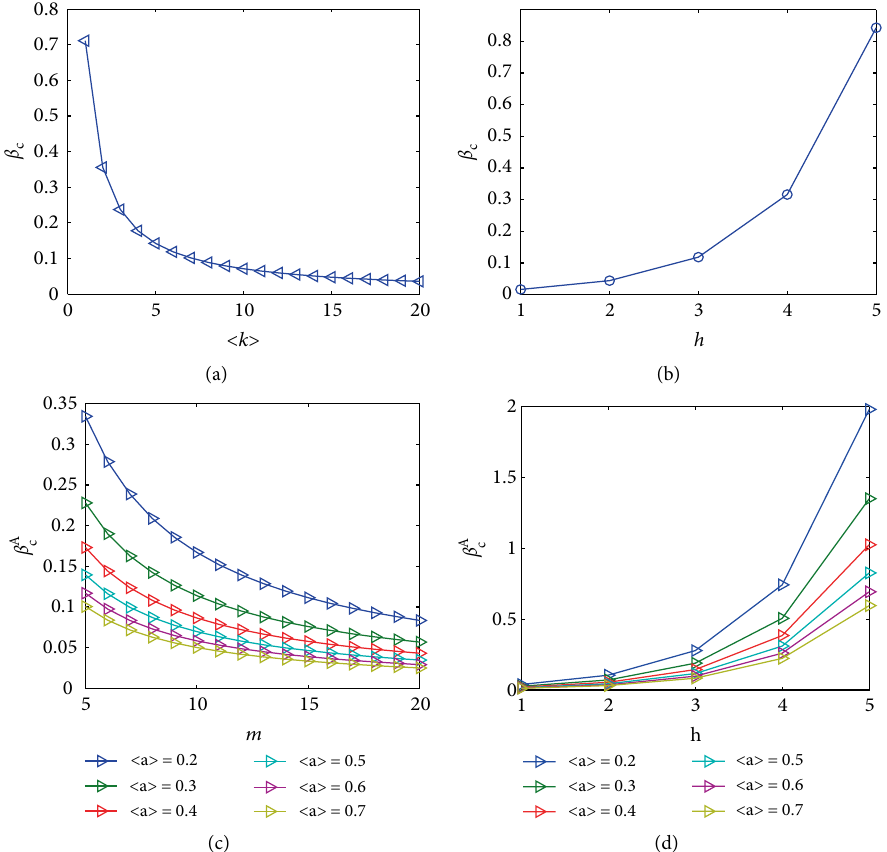
𝐴 and under different network parameters. (a) The outbreak threshold 𝑐 𝑐 against the number of intermediate state 𝑐 𝛽 𝛽